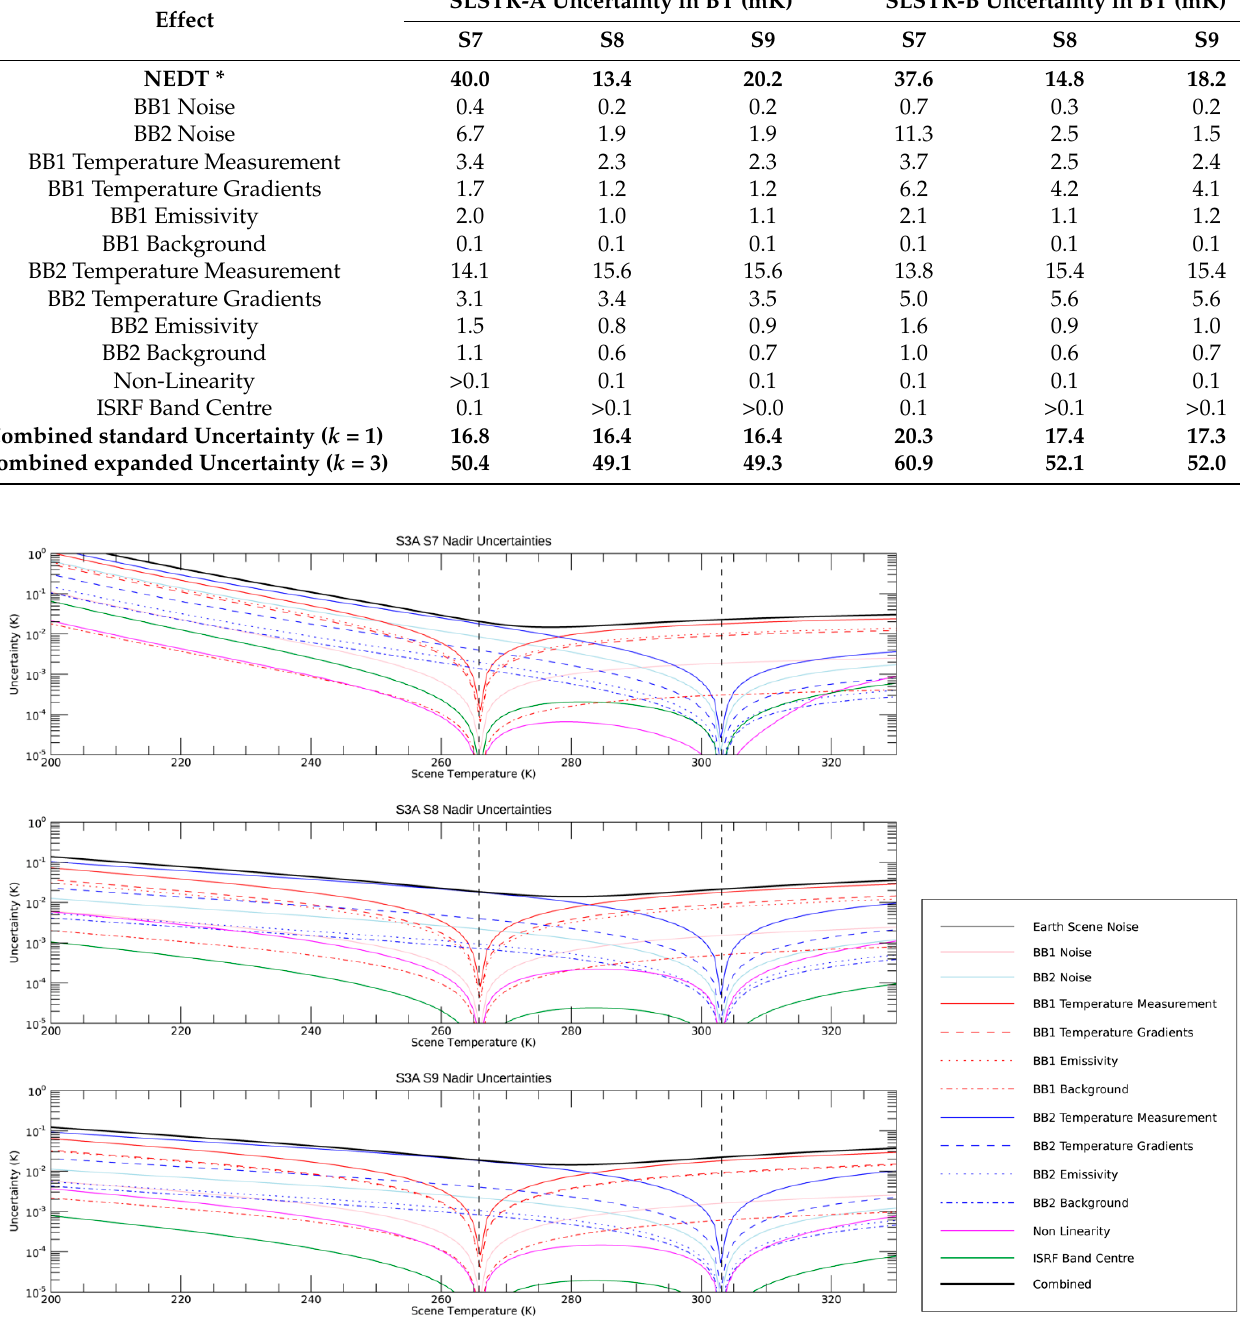
Figure 10. SLSTR-A Thermal Infrared Uncertainty Budget for a typical orbit at 1 June 2020.